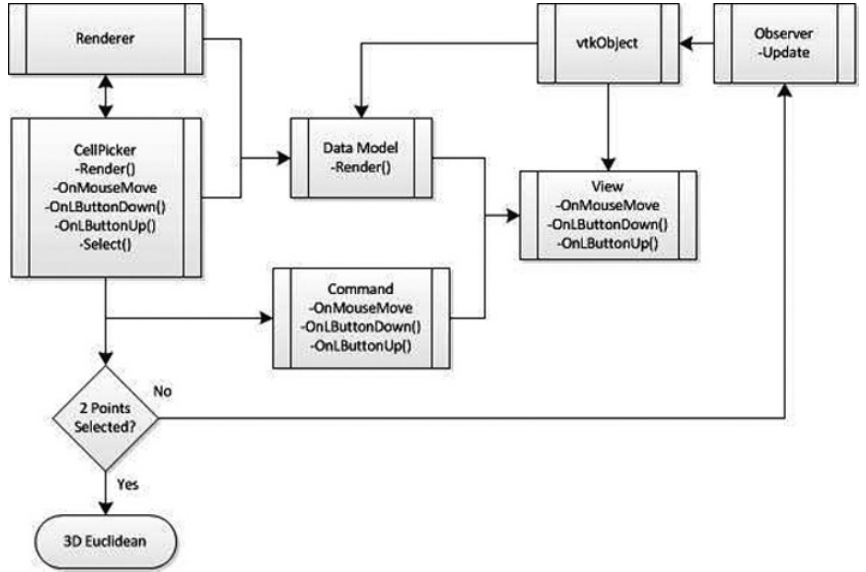
Fig. 1 - Algorithm connection between vtkPicker and renderer data channel for 3D Euclidean